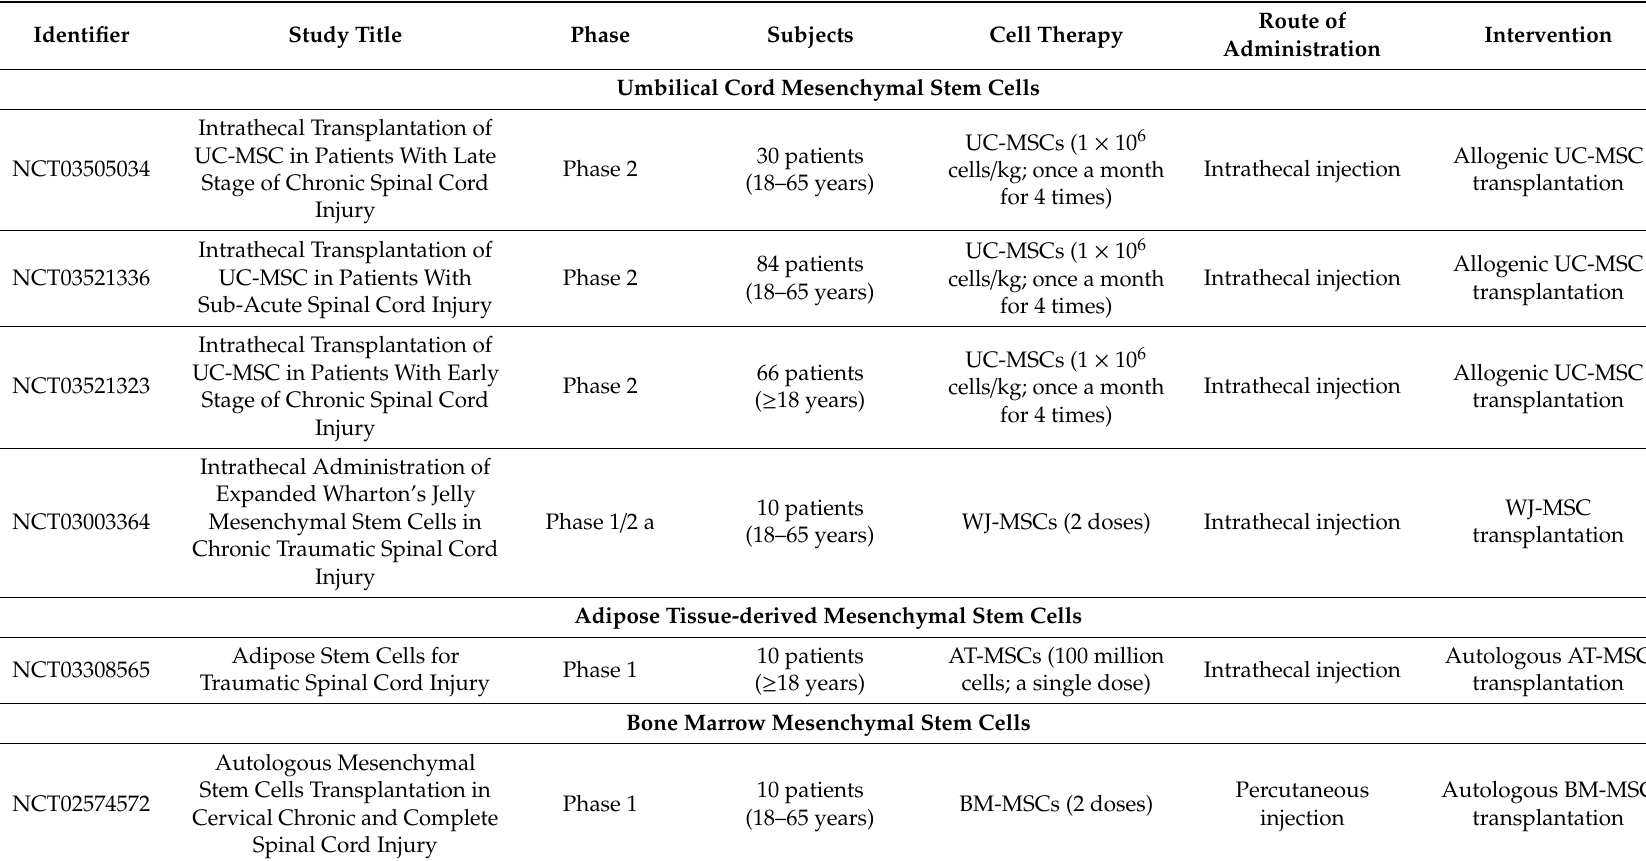
Table 2. Ongoing clinical trials of stem cell therapy in SCI (https: // clinicaltrials.gov / ). The table lists all the clinical trials active in recruitment phase or that will be important to understanding the e ffi cacy and safety of stem cell therapy in the management of